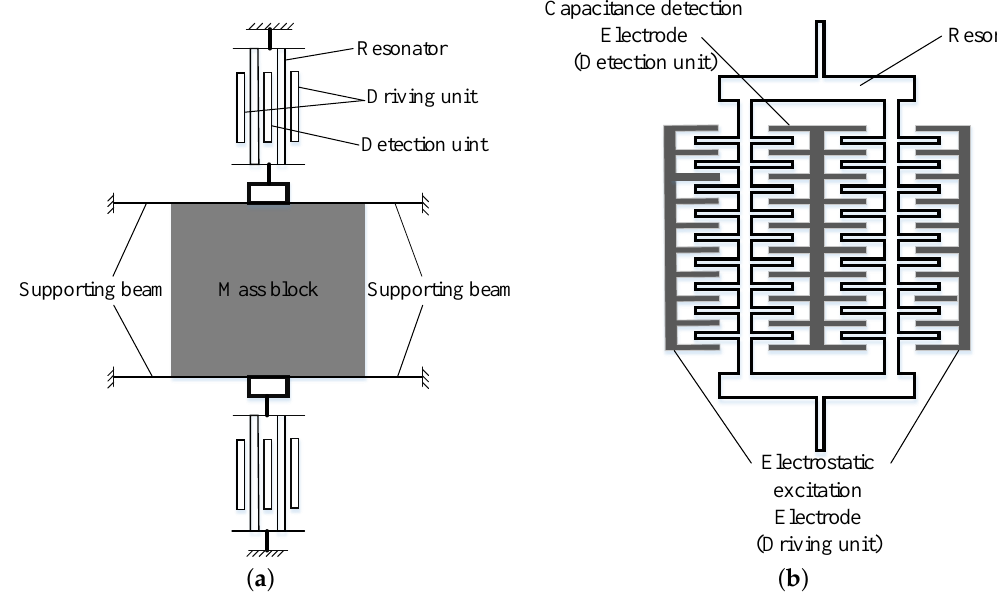
Figure 1. ( a ) structural schematic diagram and ( b ) schematic diagram of drive/detection